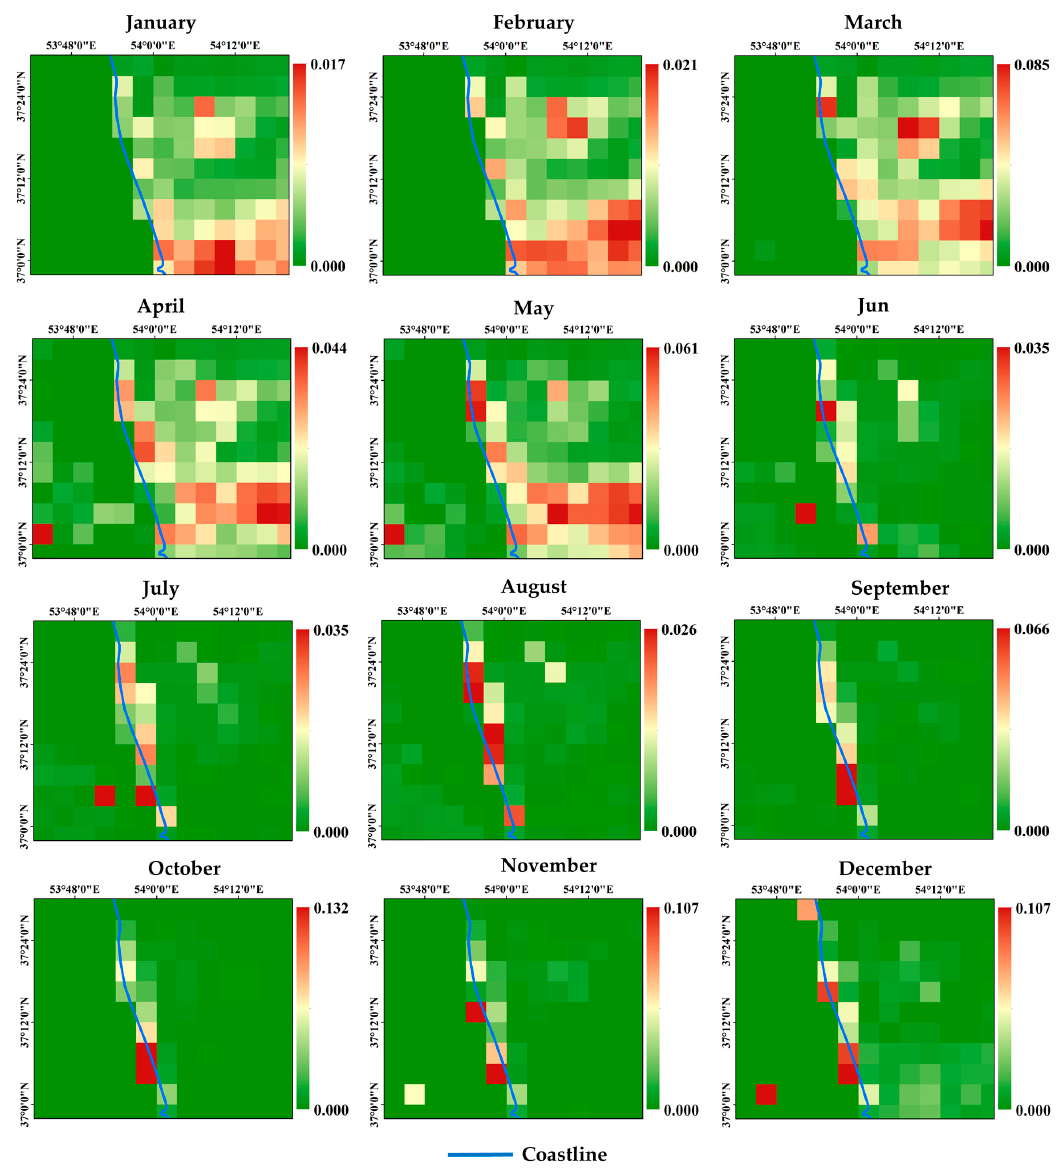
ff erent months in the period of Figure 7. Variance maps of NDVI for different months in the period of 2000–2017. Figure 7. Variance maps of NDVI for di